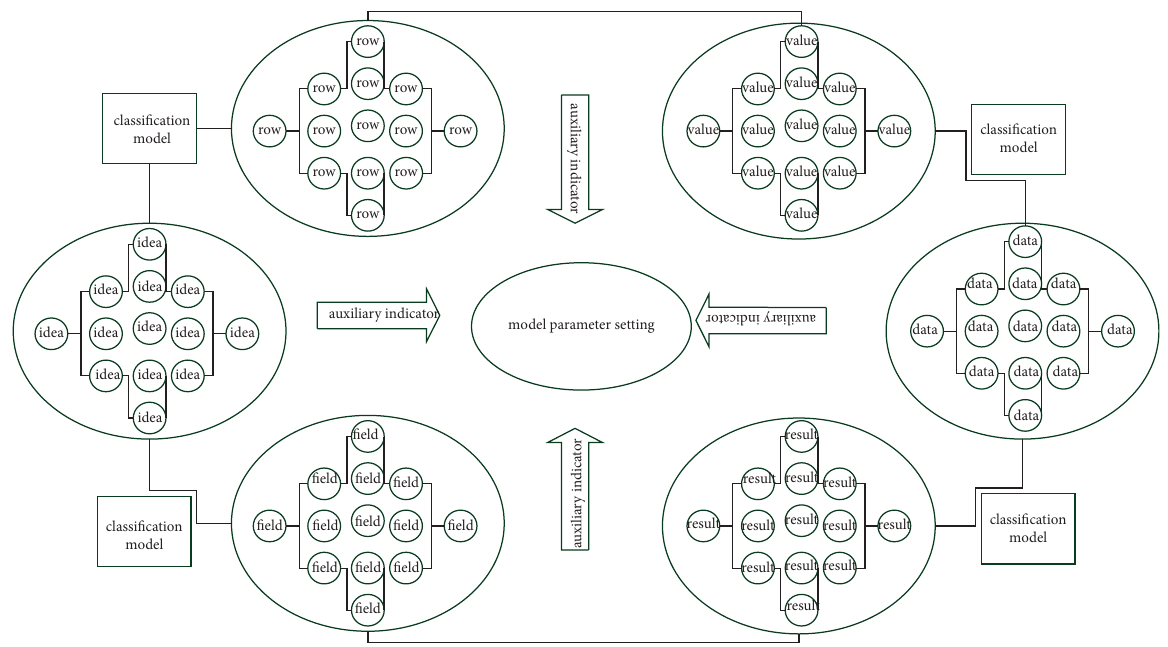
Figure 1: Machine learning algorithm